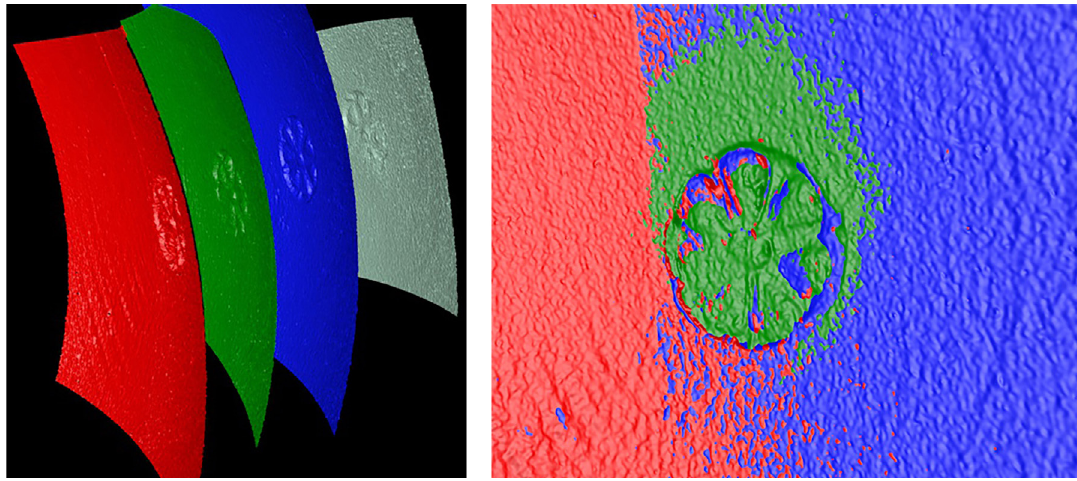
Figure 8. Matching rosettes of the Capistello shipwreck manually in Cinema4D. Each impression is characterized by different colours. The green and blue stamps show the biggest difference, which certainly indicates different punches, whereas red and green differ less and only on the edges. Illustration elaborated by L. Opgenhaffen.